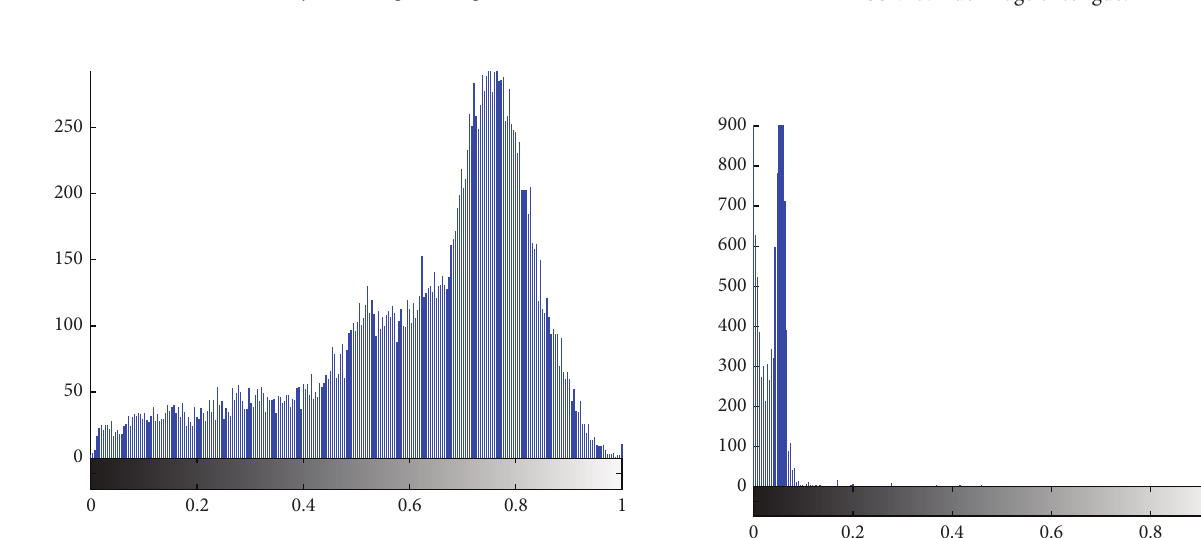
Figure 5: Hue image of tongue.